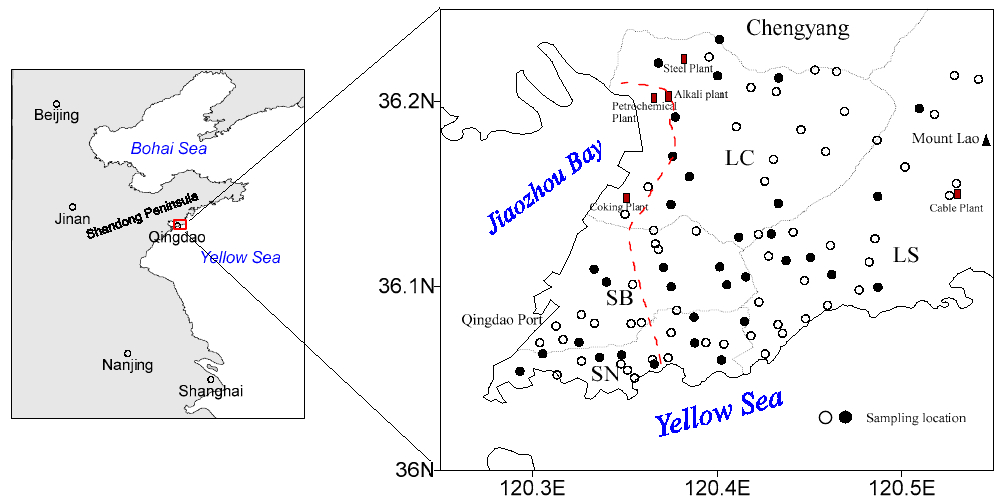
Figure 1. Atmospheric settled dust collection sites in Qingdao, China; Qingdao’s main urban area includes Shinan (SN), Shibei (SB), Licang (LC) and Laoshan (LS); west of SN, SB and LC are the old city areas of Qingdao (west of red line); the speciation of metals was analyzed in sites marked with dark solid circles.